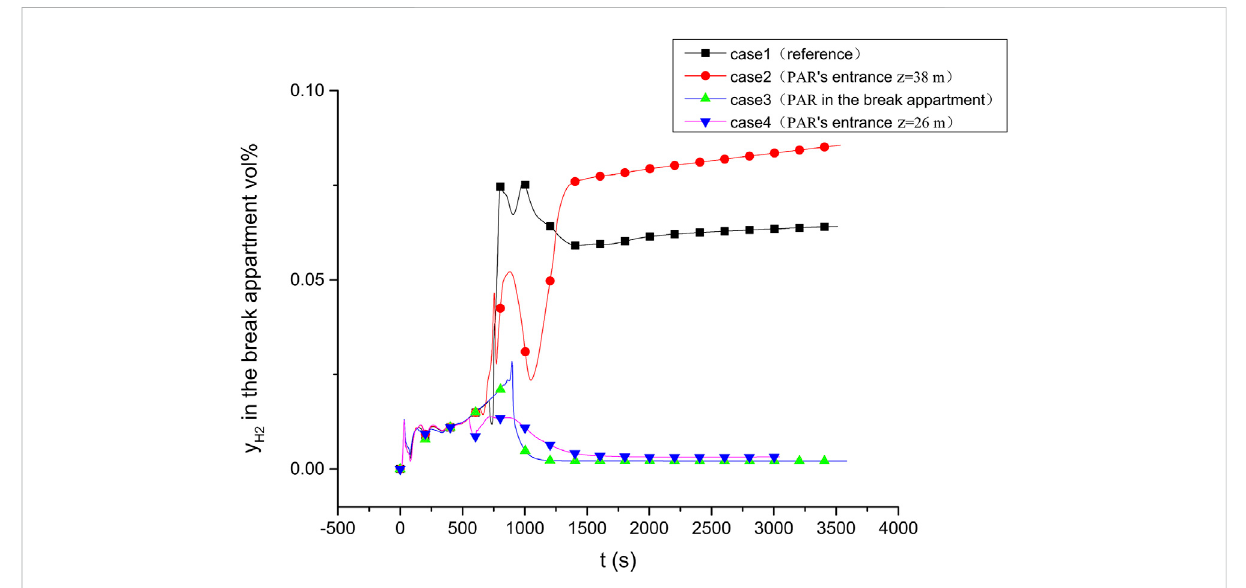
FIGURE 12 Hydrogen concentration in the break